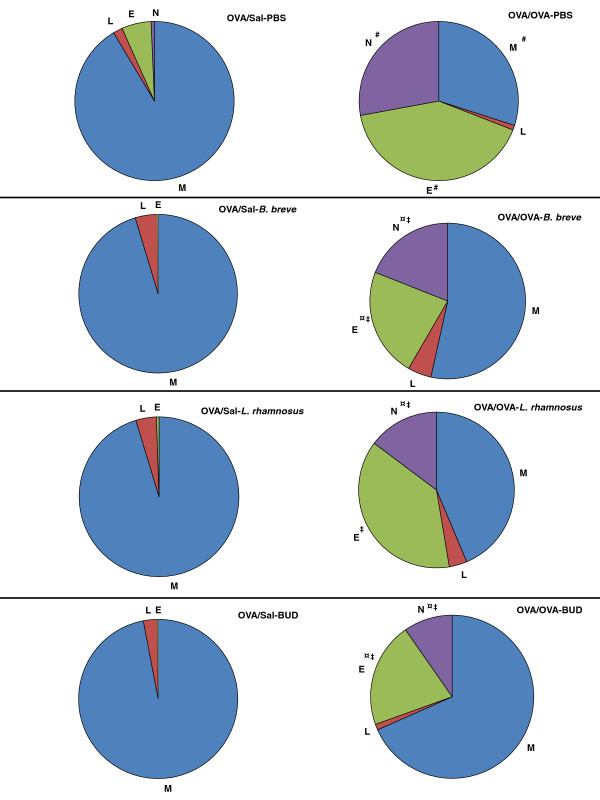
Beneficial bacteria and budesonide reduce the differential BAL fluid cell counts in chronic asthmatic mice. Pulmonary inflammation is represented by the influx of macrophages (M), lymphocytes (L), eosinophils (E) and neutrophils (N) in the BAL fluid. Differential cell counts are shown as percentages of the total cell count for each group. The charts show the mean, n = 6 mice/group. Statistical significance of differences was tested using post hoc Bonferroni’s multiple comparison test after one-way ANOVA. #Statistically significant difference (p < 0.05) compared to OVA/Sal-PBS mice. ¤Statistically significant difference (p < 0.05) compared to OVA/OVA-PBS mice. ‡Statistically significant difference (p < 0.05) compared to the OVA/Sal group in each treatment group. BUD = budesonide.